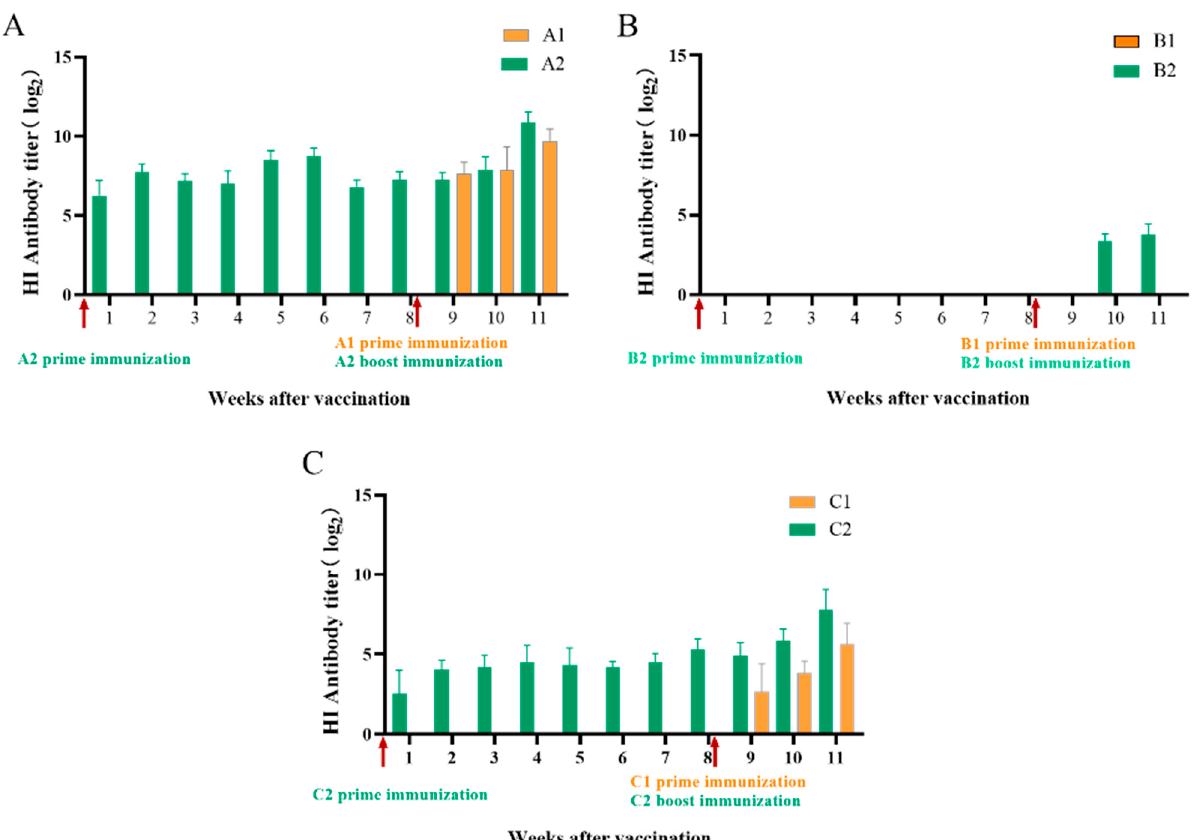
Figure 1. Hemagglutination inhibition antibody titers in chickens after prime and booster immunization. Serum samples (n = 10) were collected every week after vaccination until 11 weeks. Antibody titers were detected by HI test with 4 HA units prepared by the 2019 − HB65 ( A ), 2019 − HB68 ( B ), and 2020 − JS80 ( C ). The antibody titers were expressed in the log 2 form. Bars indicate means ± standard deviations.